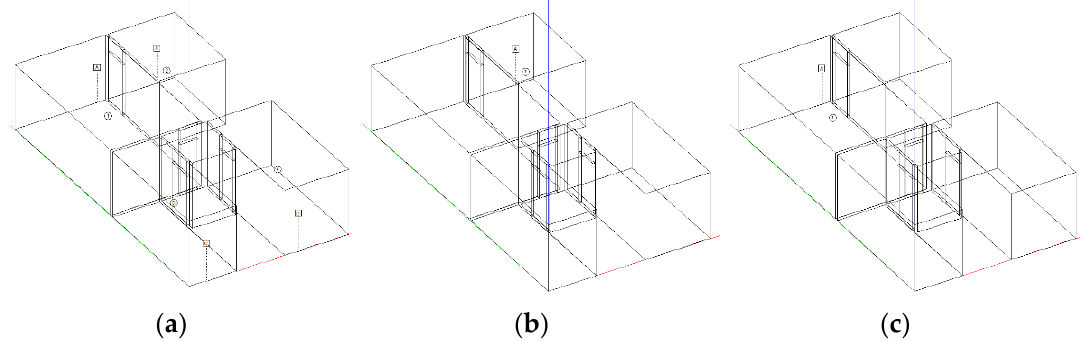
Figure 16. Three-room apartment. “Day” configuration: ( a ) all CVM on, ( b ) only kitchen CVM on, ( c ) only living room CVM on.